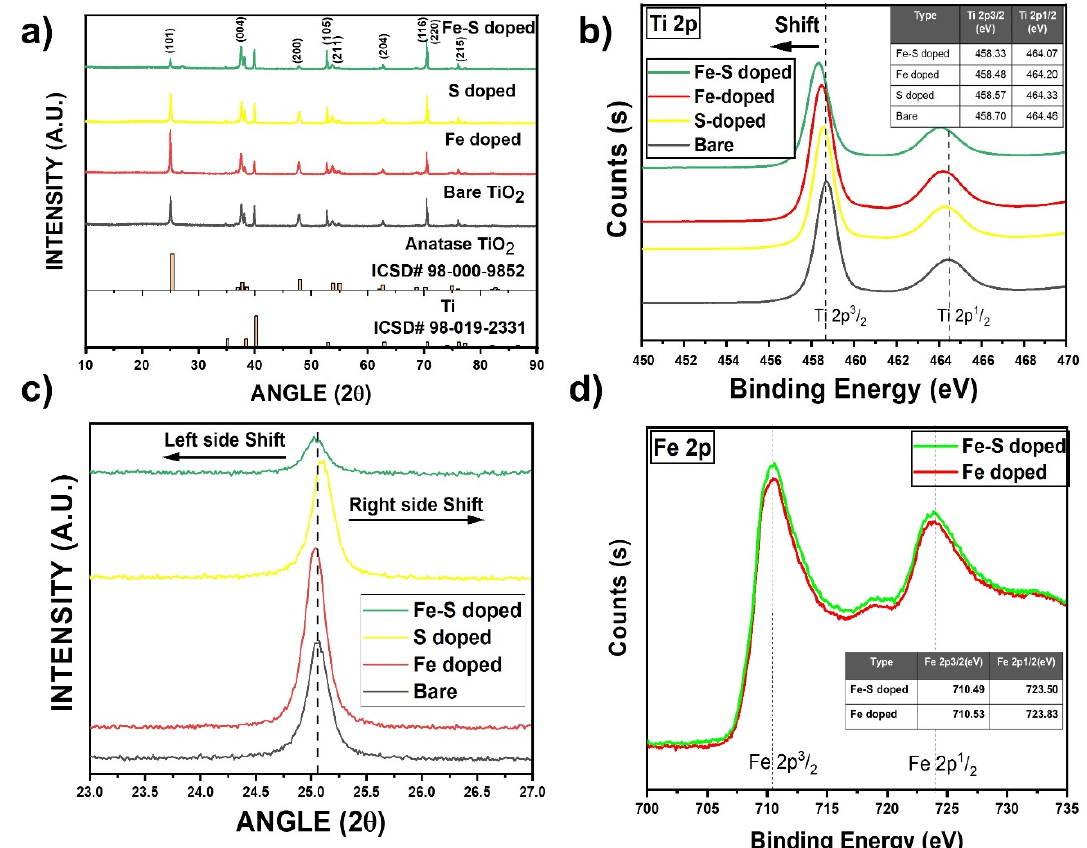
Figure 3. ( a ) XRD results for bare, Fe, S, and Fe-S doped TNTs. ( b ) Ti 2p XPS results for bare, Fe, S, and Fe-S doped TNTs showing a peak shift towards lower energies due to the presence of doped elements in the TNTs framework. ( c ) A zoomed in view of (101) XRD peak showing clear peaks shift for Fe, S, and Fe-S doped TNTs. ( d ) Fe 2p XPS results for Fe, Fe-S doped TNTs showing the incorporation of Fe in the TiO 2 framework.